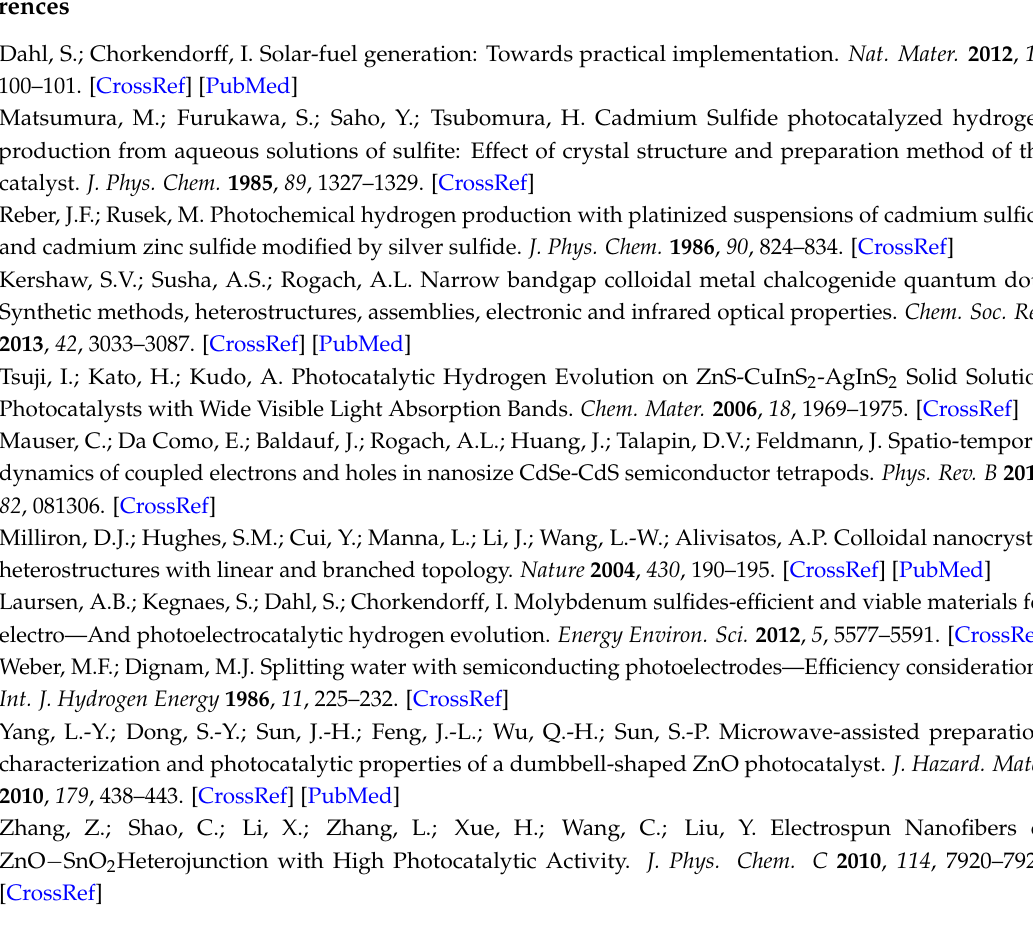
Figure S1: Diffuse reflectance spectra of the as-prepared composite photocatalyhst with different ratio of Ag:Zn. Figure S2: The H 2 evolved from water under solar light over AgInS 2 -Ag 2 S-ZnS obtained with Ag:Zn = 1:1. Figure S3: Photocatalytic H 2 evolution under solar-light irradiation with the same sample as in Figure S2. It is showing that the addition of (NH 4 ) 2 PtCl 6 improved the production rate of H 2 though the original catalyst also shows the good activity towards H 2 evolution. Figure S4: BET surface area and H 2 production of AgInS 2 - x Ag 2 S- y ZnS- z In 6 S 7 with different molar ratios of Ag + to Zn 2+ ions. Figure S5: An SEM image of the AgI